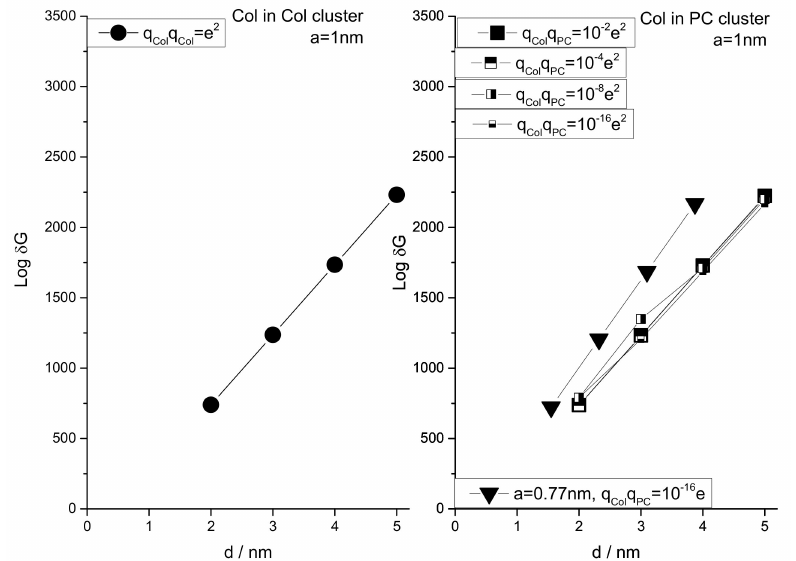
Figure 11. Energy for inter particle distance for four SCI orders. The inter particle separation d is deducted for each SCI order considering a close drug–drug (left panel) or drug–lipid (right panel) packing